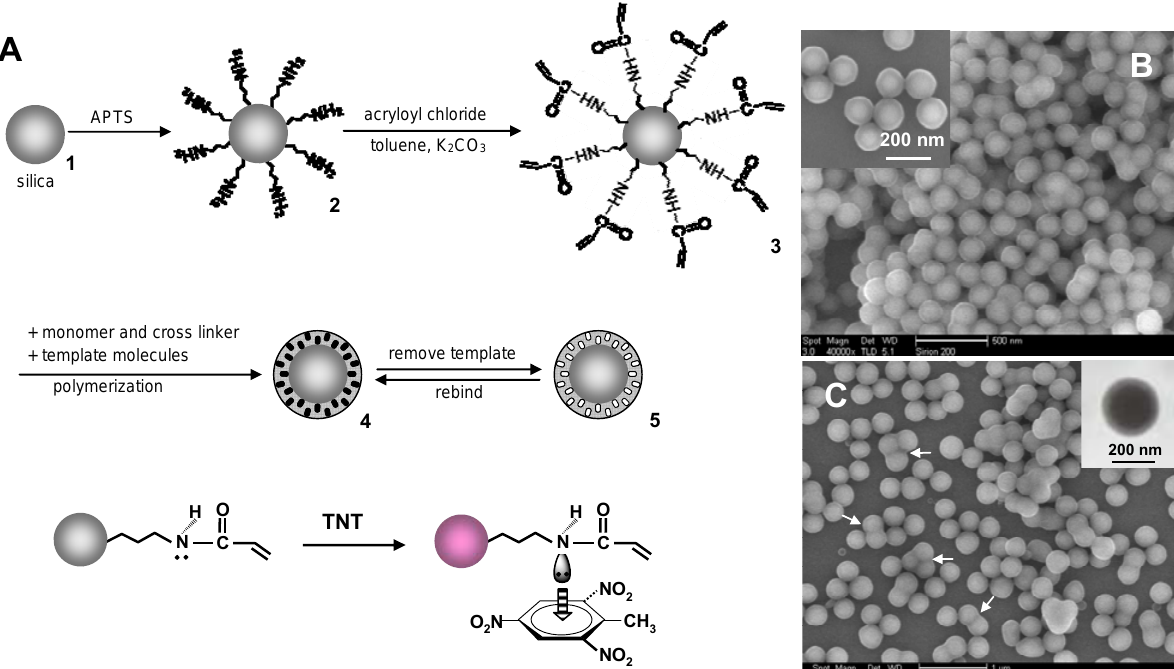
Figure 3. (A) Schematic illustration of molecular imprinting on silica nanoparticles. (B) SEM image of SiO @TNT-MIP particles with 100-nm-sized core (inset is 2 @TNT-MIP particles with high-magnification SEM image). (C) SEM image of SiO 2 200-nm-sized core (inset is high-magnification TEM image). Reprinted with permission from [16]. Copyright 2007 American Chemical